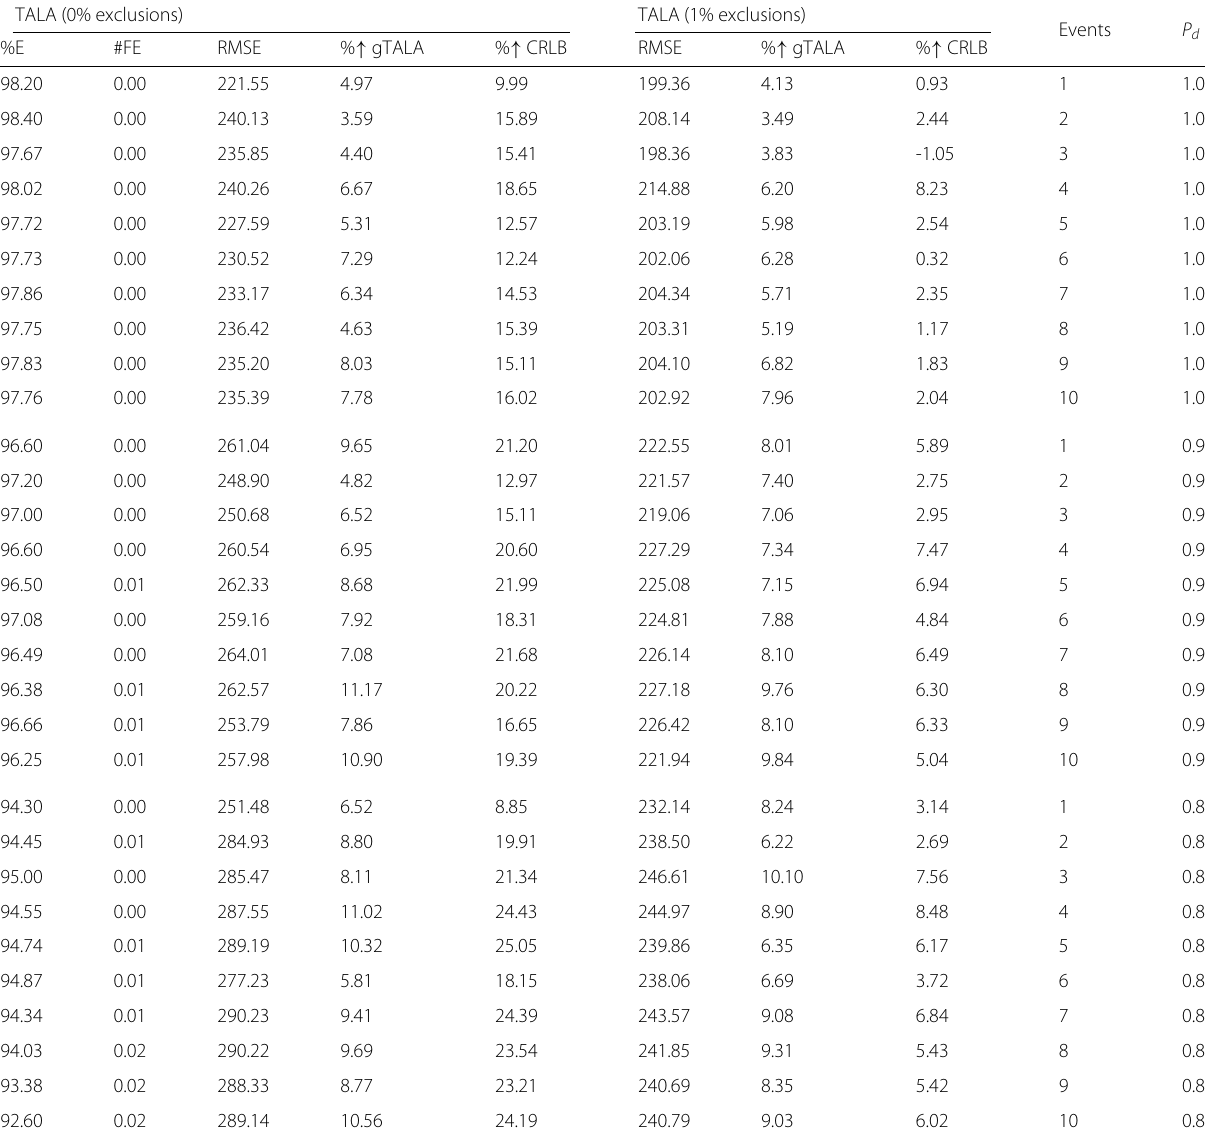
Table 5 Summary of the TALA geo-location performance for scenario